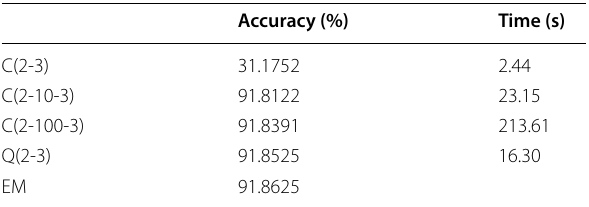
Fig. 7 Decision boundaries of EM and neural networks, including C and Q neural networks with different numbers of neurons. The notation ( · ) stands for the architecture of a neural network as described in Eq. 15 Table 1 The average accuracy of and time needed by EM algorithm, Q and C neural networks with different numbers of neurons in 2D spaces with two Gaussian clusters plus a background. The notation ( · ) stands for the architecture of a neural network as described in Eq.